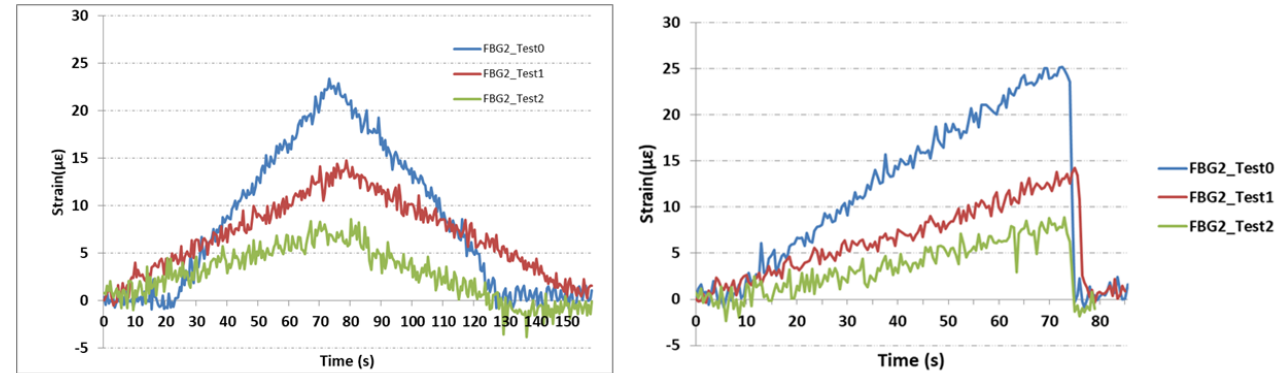
Figure 12. Strain measurements from the FBG2 sensor. Left : Strain measurements from the test profile of gradual changes; Right : Strain measurements from the test profile of sudden changes.